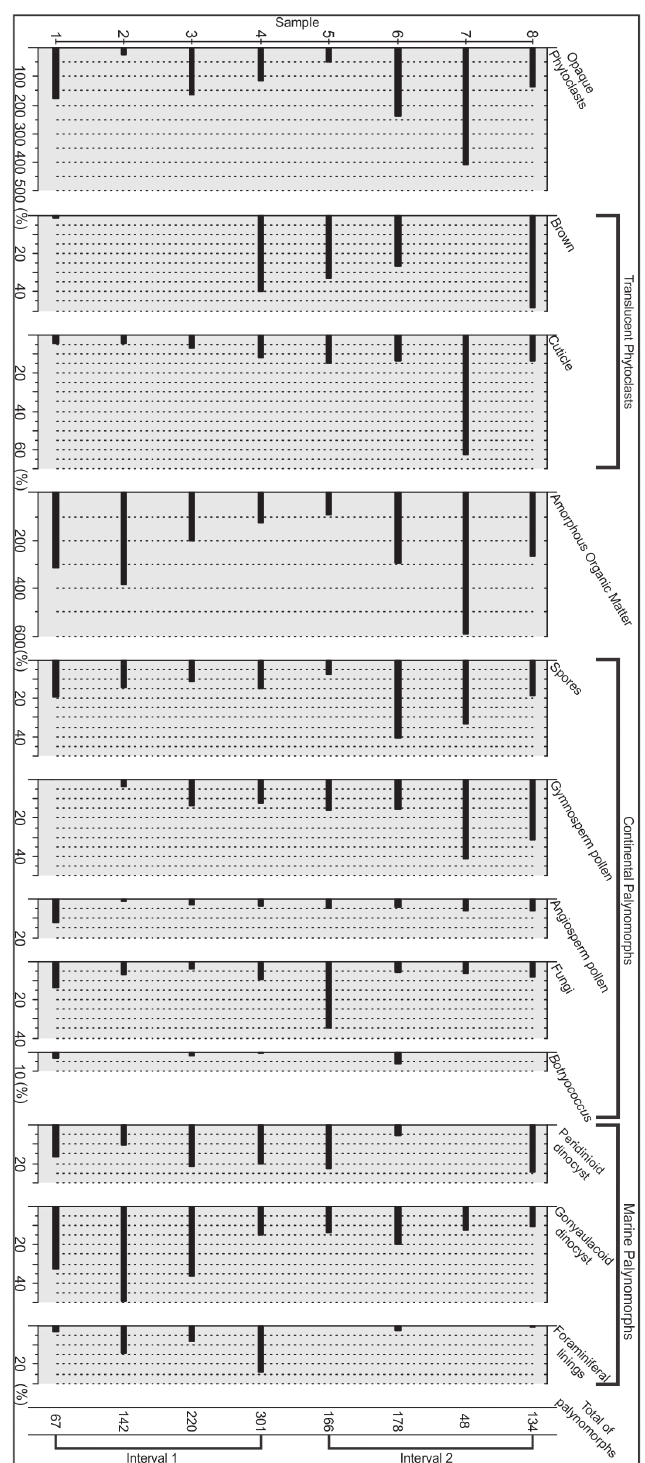
Fig. 4 - Relative frequencies (%) of particulate organic matter along the study section of the well 2-TG-96-RS and the two paleoenvironmental intervals characterized